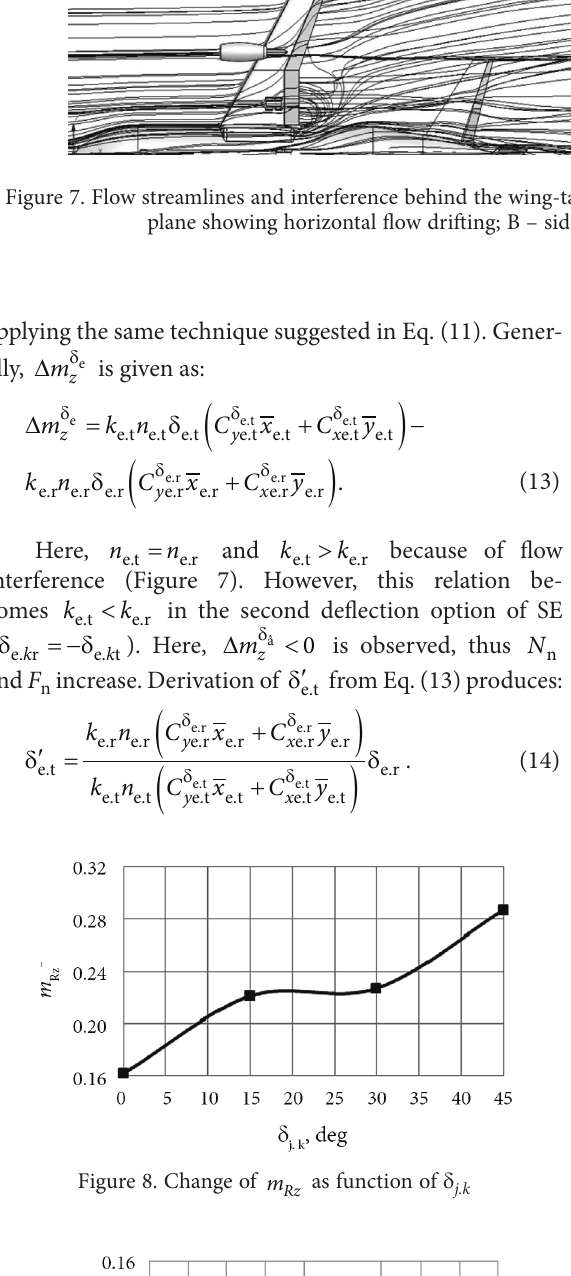
Figure 9. Change of